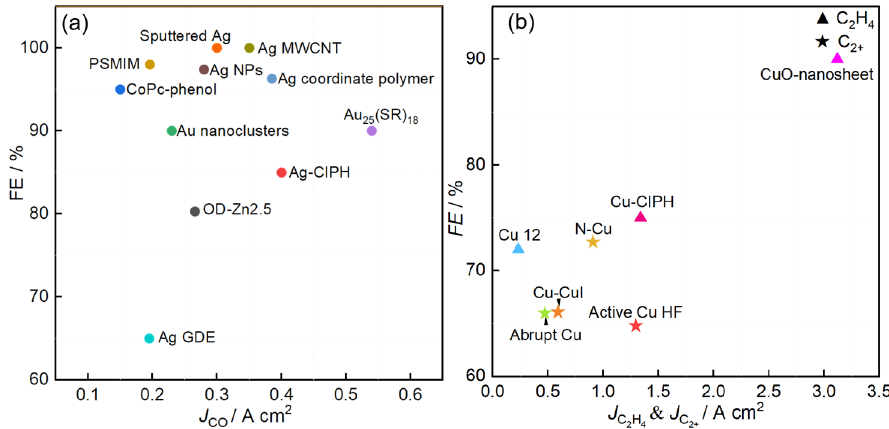
Figure 11. Partial current density and Faraday efficiency of ( a ) CO, ( b ) C 2 H 4 , and C 2+ products in CO 2 RRs with state-of-the-art catalysts.